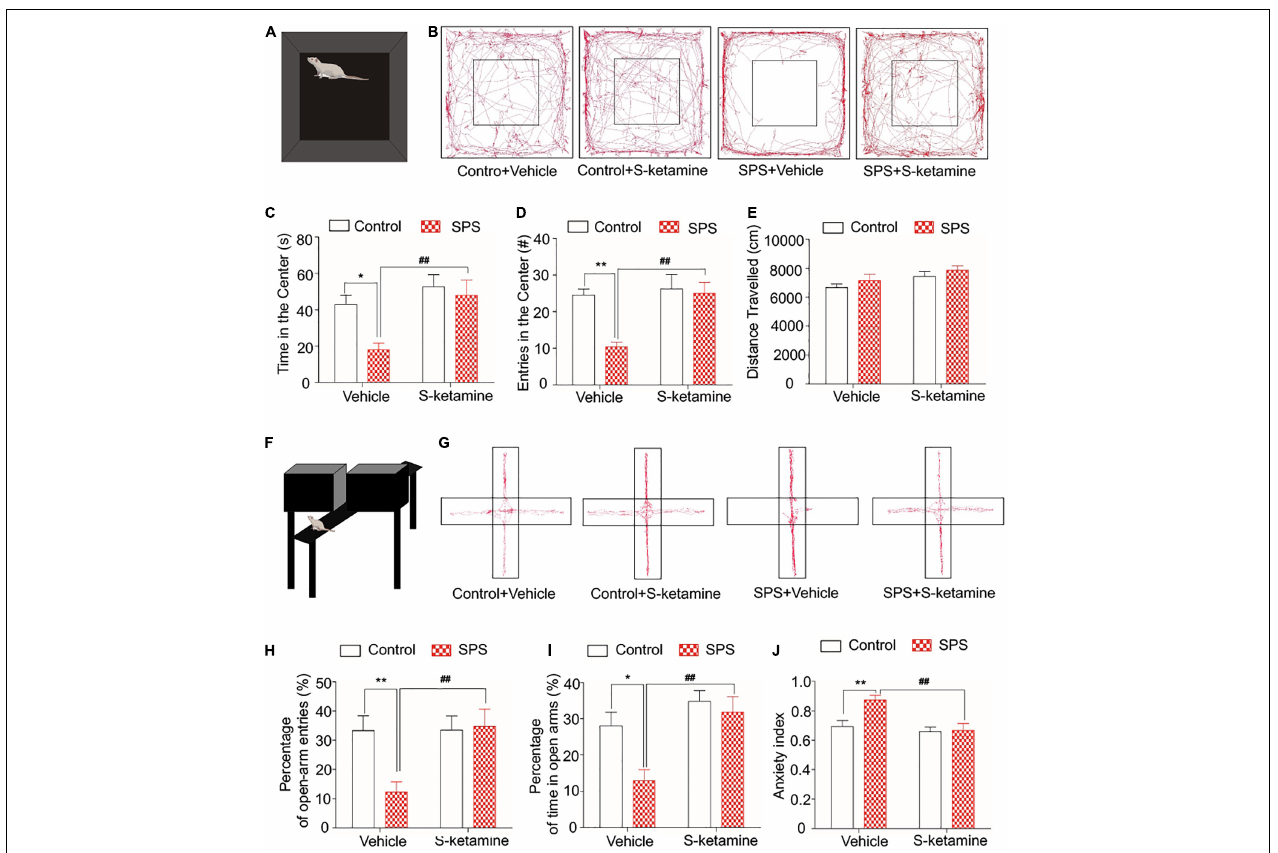
FIGURE 2 | S-ketamine alleviates anxiety-like behaviors in the SPS-exposed rats. Rats were randomly assigned into control + vehicle group, SPS + vehicle group, control + S-ketamine 5 mg/kg group and SPS + S-ketamine 5 mg/kg group. n = 8 per group. (A) Diagram of the open field test. (B) Movement paths in the open field. (C) Time in the center. (D) Entries in the center. (E) Distance traveled. (F) Diagram of the elevated plus maze test. (G) Movement paths in the open and closed arms. (H) Percentage of open-arm entries. (I) Percentage of time in open arms. (J) Anxiety index. * P < 0.05, ** P < 0.01, control + vehicle group vs. SPS +